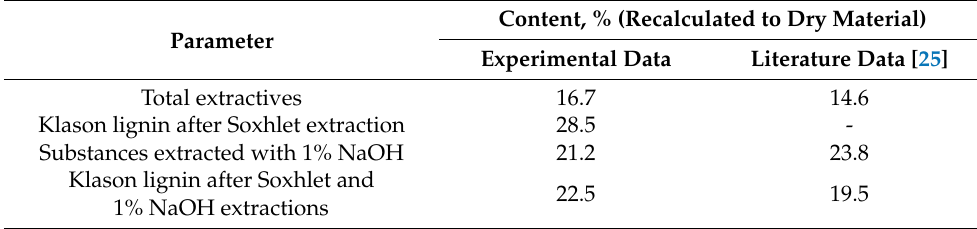
Table 1. Chemical composition of the birch phloem under study. Content, % (Recalculated to Dry Material) Parameter Experimental Data Literature Data